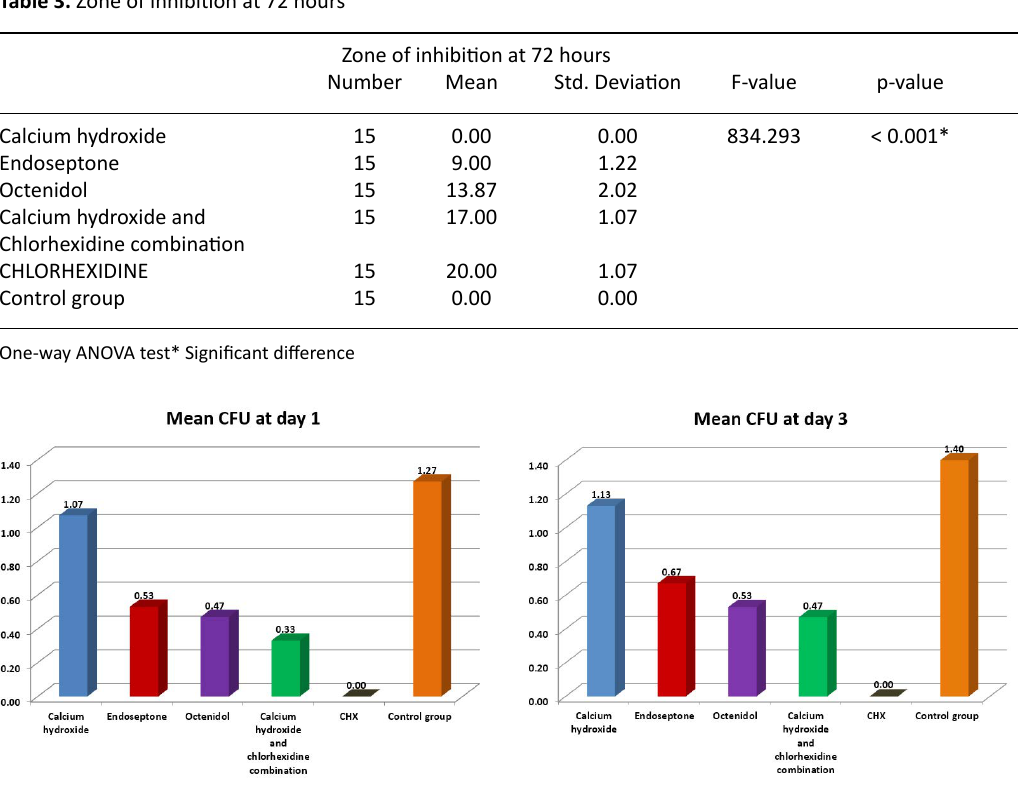
Fig. 3. CFU at day 1 by various medicament Fig. 4. CFU at day 3 by various